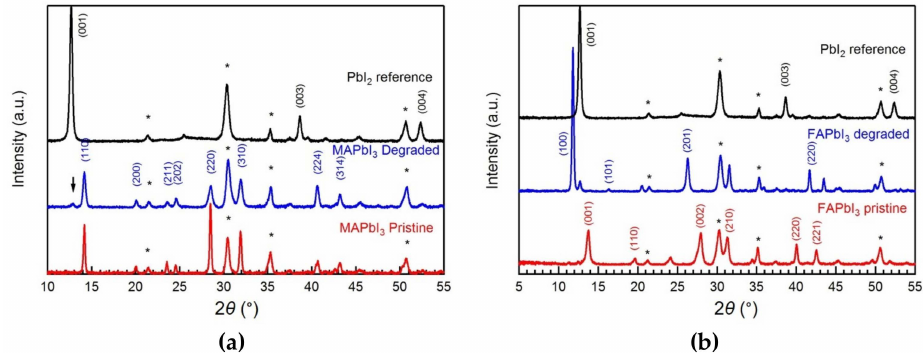
Figure 4. XRD data of MAPbI 3 and FAPbI 3 sample before and after water vapor exposure. PbI 2 spectra are shown as a reference. Peaks marked with * is from indium-tin-oxide (ITO) substrate. ( a ) XRD spectra of the MAPbI 3 sample before and after water exposure. ( b ) XRD spectra of the FAPbI 3 sample before and after water